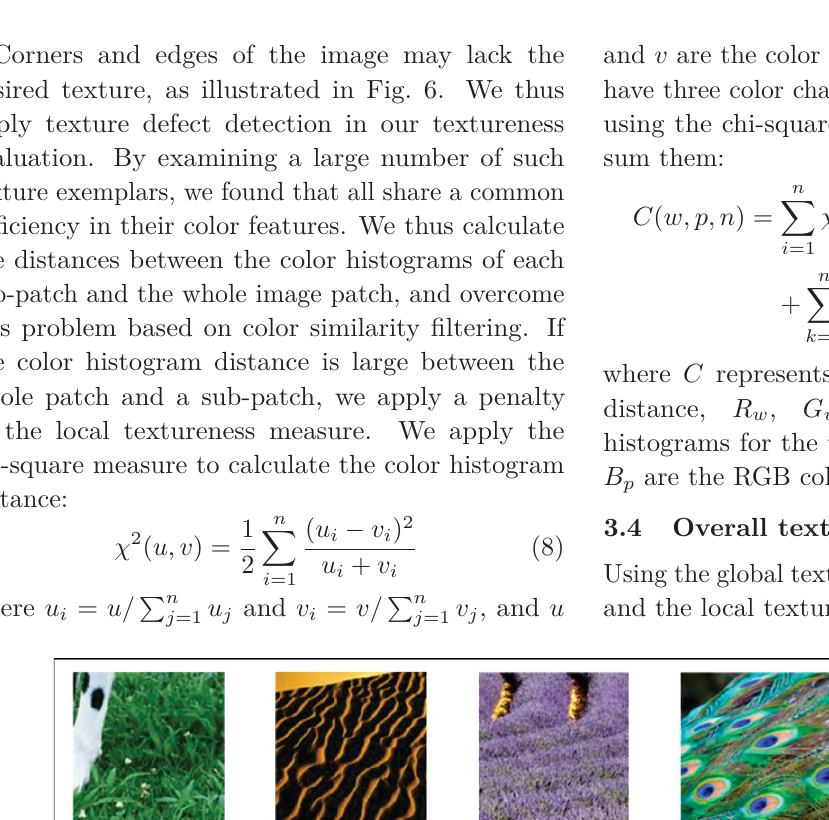
Fig. 5 Local textureness measure.